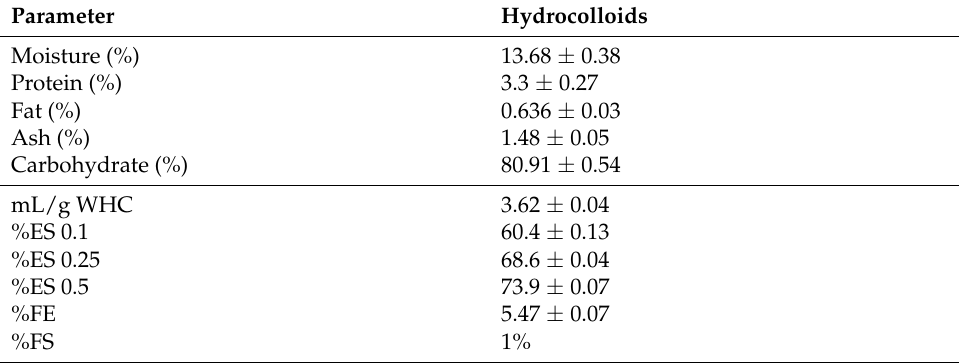
Table 1. Proximal composition and functional properties of hydrocolloids from Pereskia bleo leaves. WHC: water holding capacity, ES: emulsifying stability, FE: foaming capacity, and FS: Foam